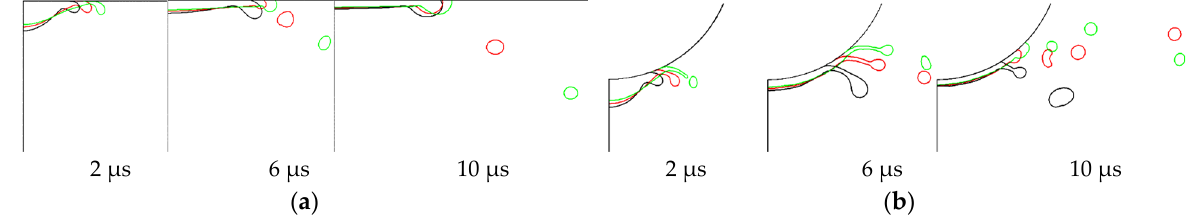
Figure 12. Droplet state diagram when the initial velocity is 8 m/s (black), 10 m/s (red), and 12 m/s (green): ( a ) droplet impacting flat wire; ( b ) droplet impacting circular wire.